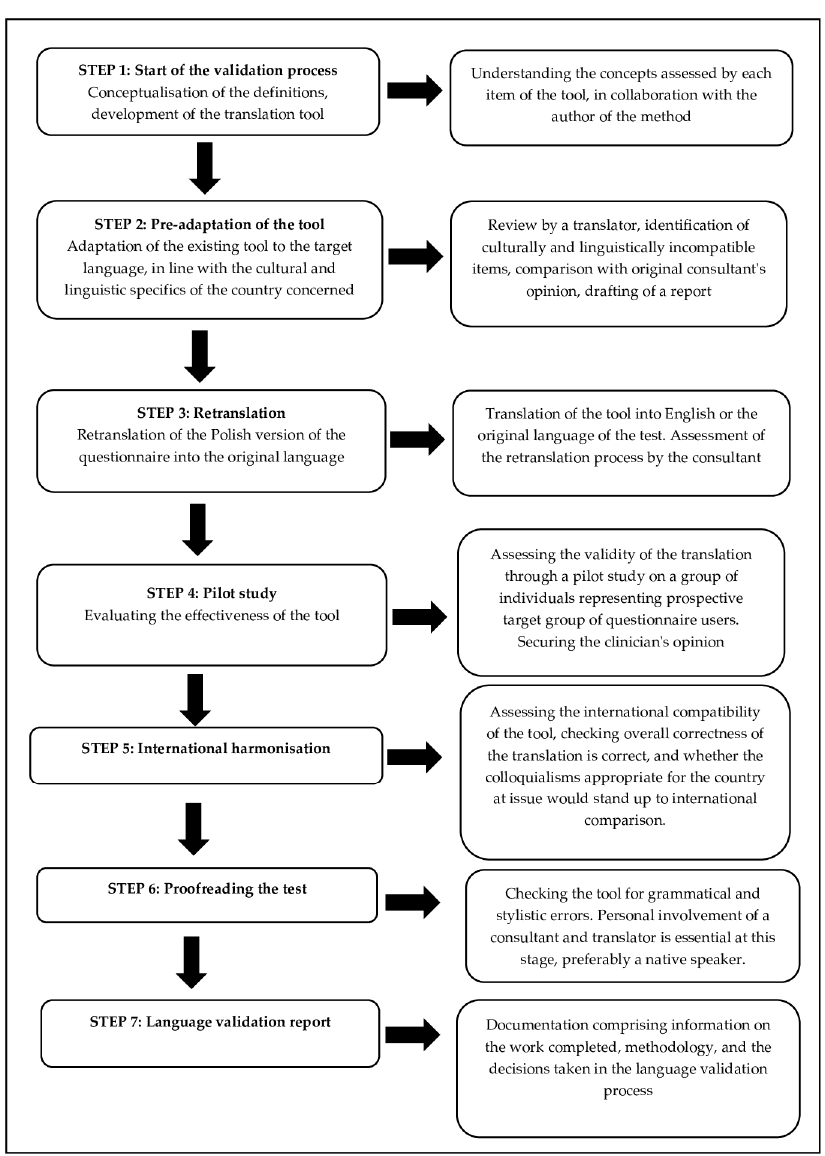
Figure 1. Diagram showing the linguistic validation process for the Polish cultural context, whilst making use of the procedures outlined in the Linguistic Validation Manual for Patient-Reported Outcomes (PRO) Instruments, as published by the MAPI Institute.